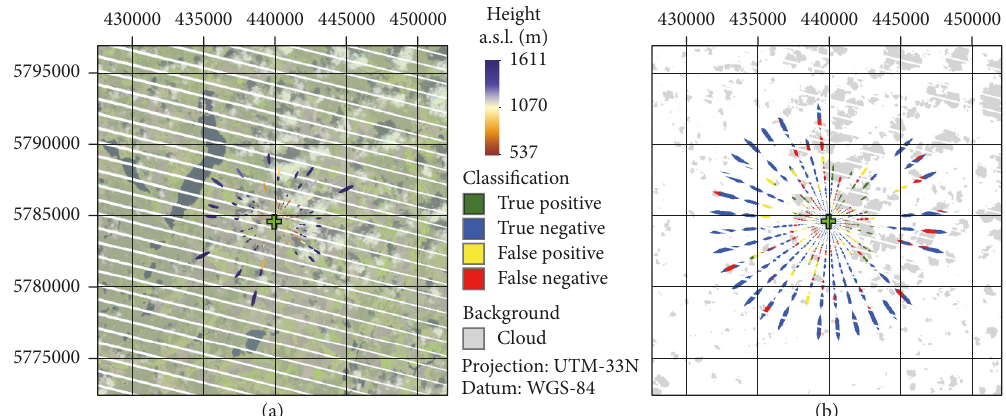
Figure 5: (a) Evaluation for 5 July 2011, 09:50 UTC. Ellipse colours represent height, ETM+ true-colour composite as background image. The position of the NubiScope is marked with a green cross. Only ellipses which passed the cloud test are presented; cloudless sky ellipses are not shown. (b) Evaluation of classifications with Fmask as reference. For the purpose of visualization, the cloud ellipses detected by the NubiScope overlay the Landsat images.